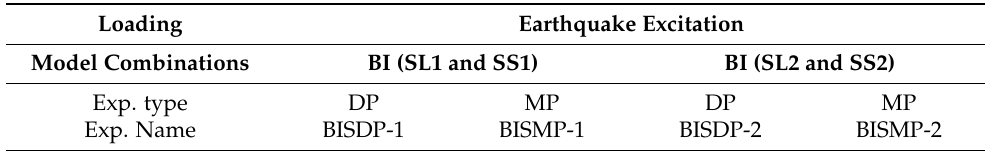
Table 4. Experiments of stiffer base-isolated models.